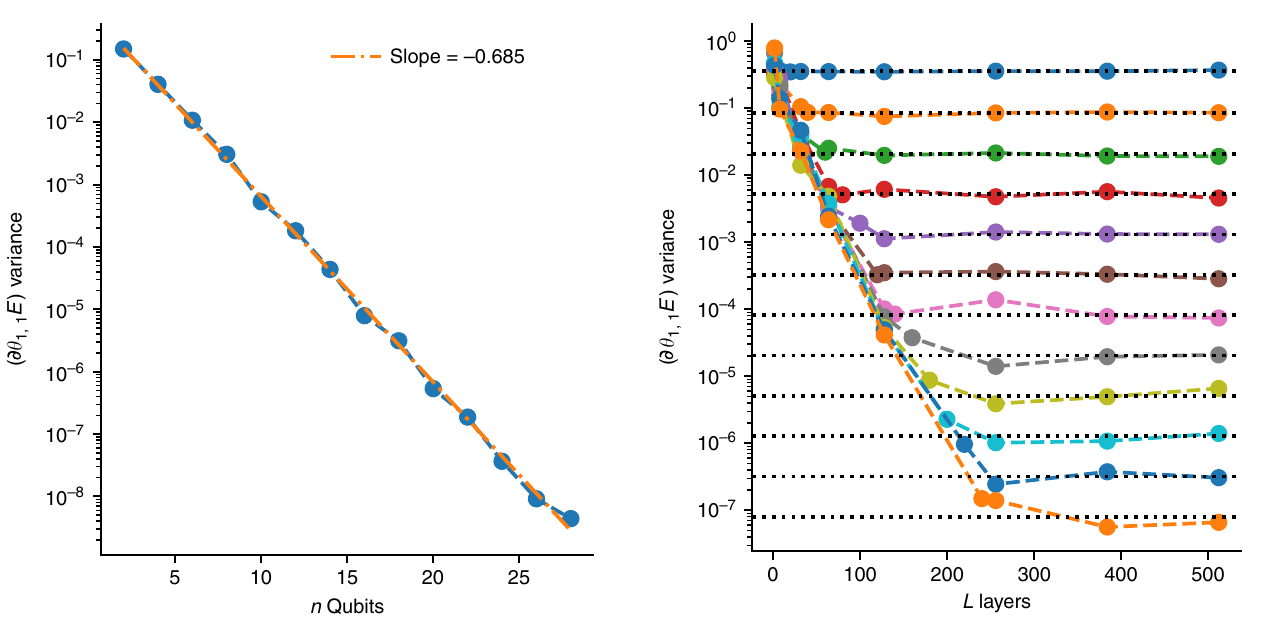
Fig. 3 Exponential decay of variance. The sample variance of the gradient of the energy for the fi rst circuit component of a two-local Pauli term ∂ θ plotted as a function of the number of qubits on a semi-log plot. As predicted, an exponential decay is observed as a function of the number of qubits, n , for both the expected value and its spread. The slope of the fi t line is indicative of the rate of exponential decay as determined by the operator